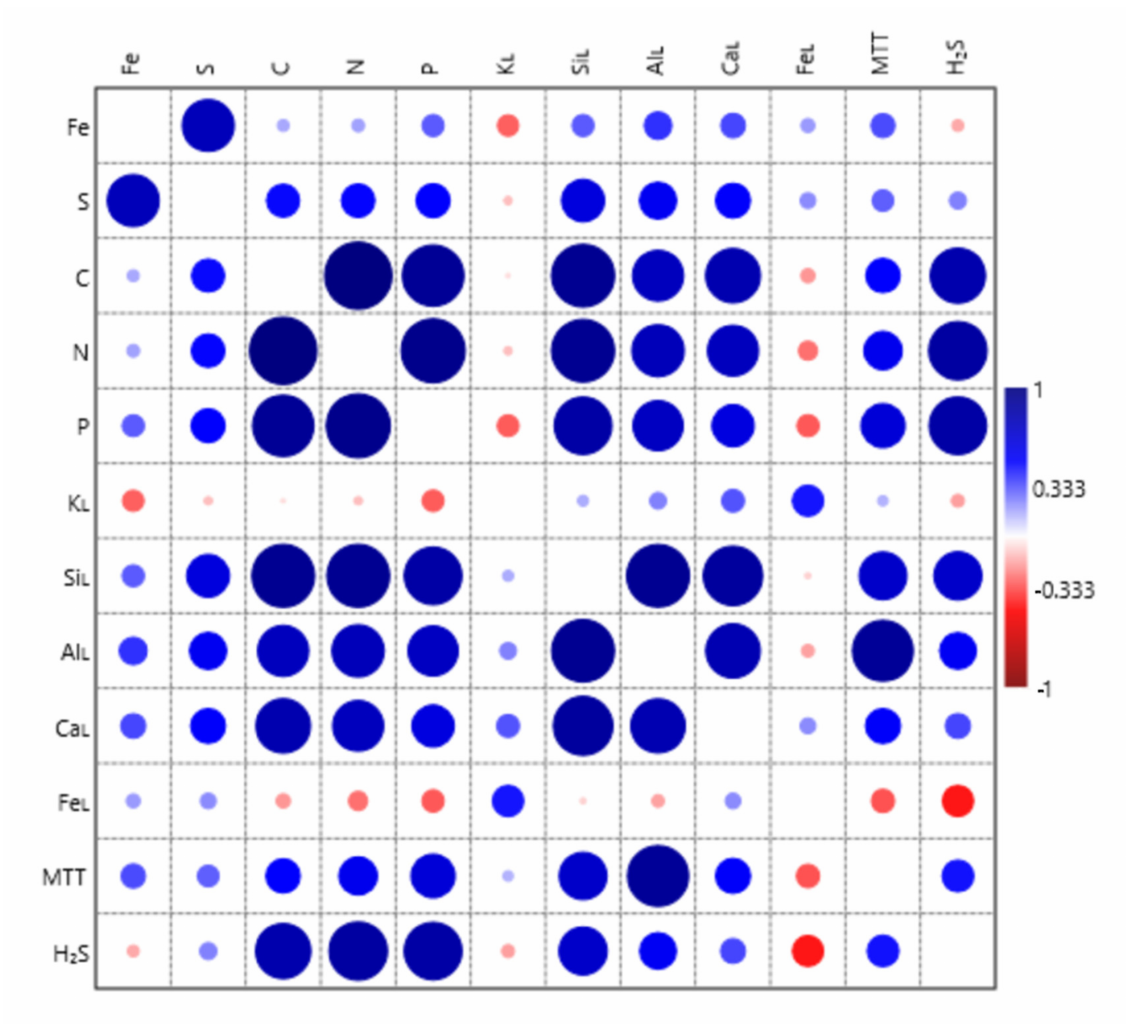
Figure 2. Relations between elemental composition and microbial processes in clay materials. “L” after the symbol of an element indicates